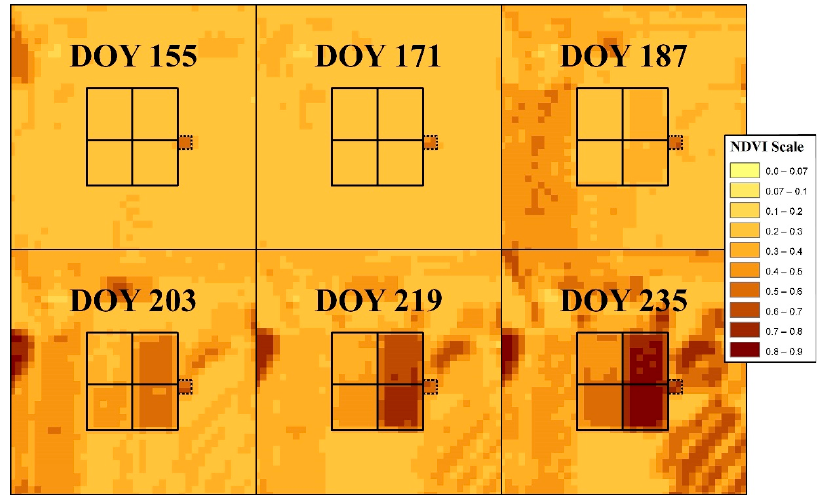
Figure 3. NDVI maps with the lysimeter fields (solid lines) and weather station grass field (dotted lines) boundaries shown for DOYs 155, 171, 187, 203, 219, and 235, derived from reflectance images courtesy of the U.S. Geological